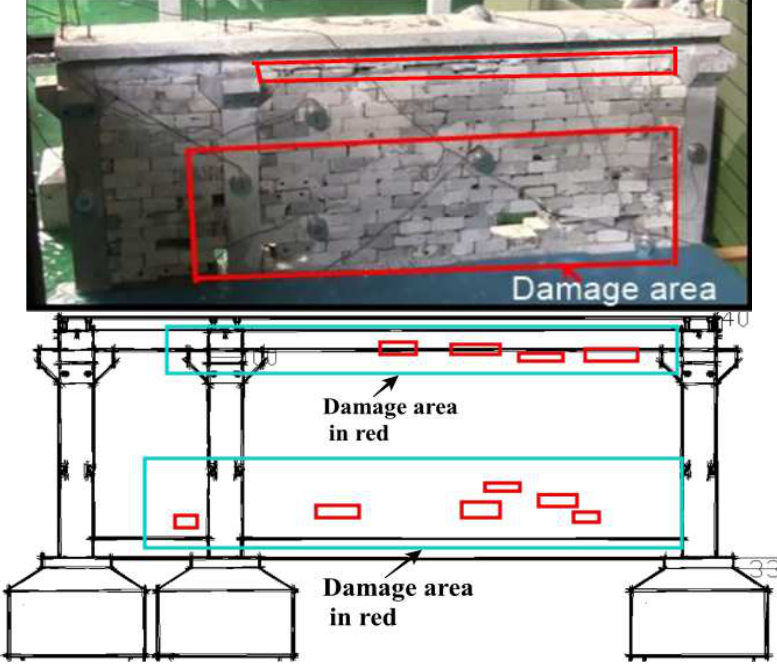
Figure 17. Damages of the frame after the Test 2.